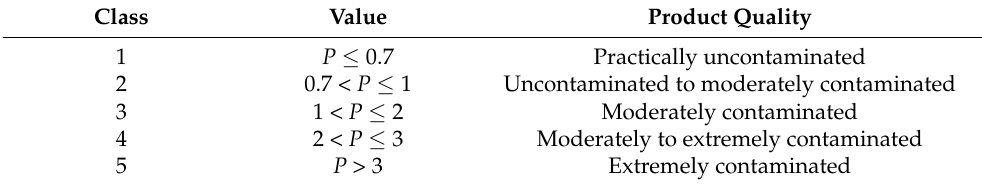
Table 2. The product quality